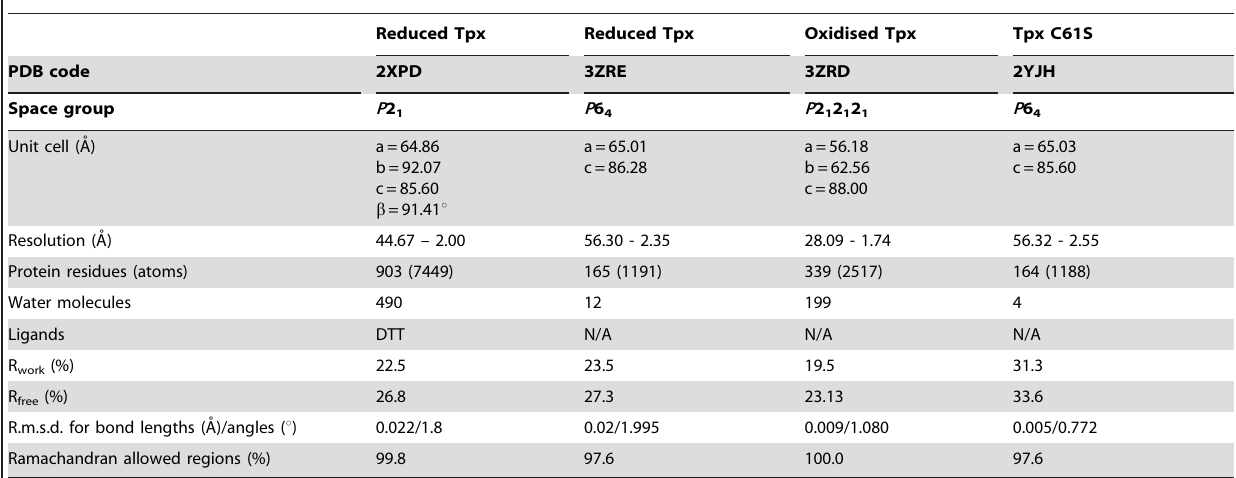
Table 1. Refinement statistics for reported